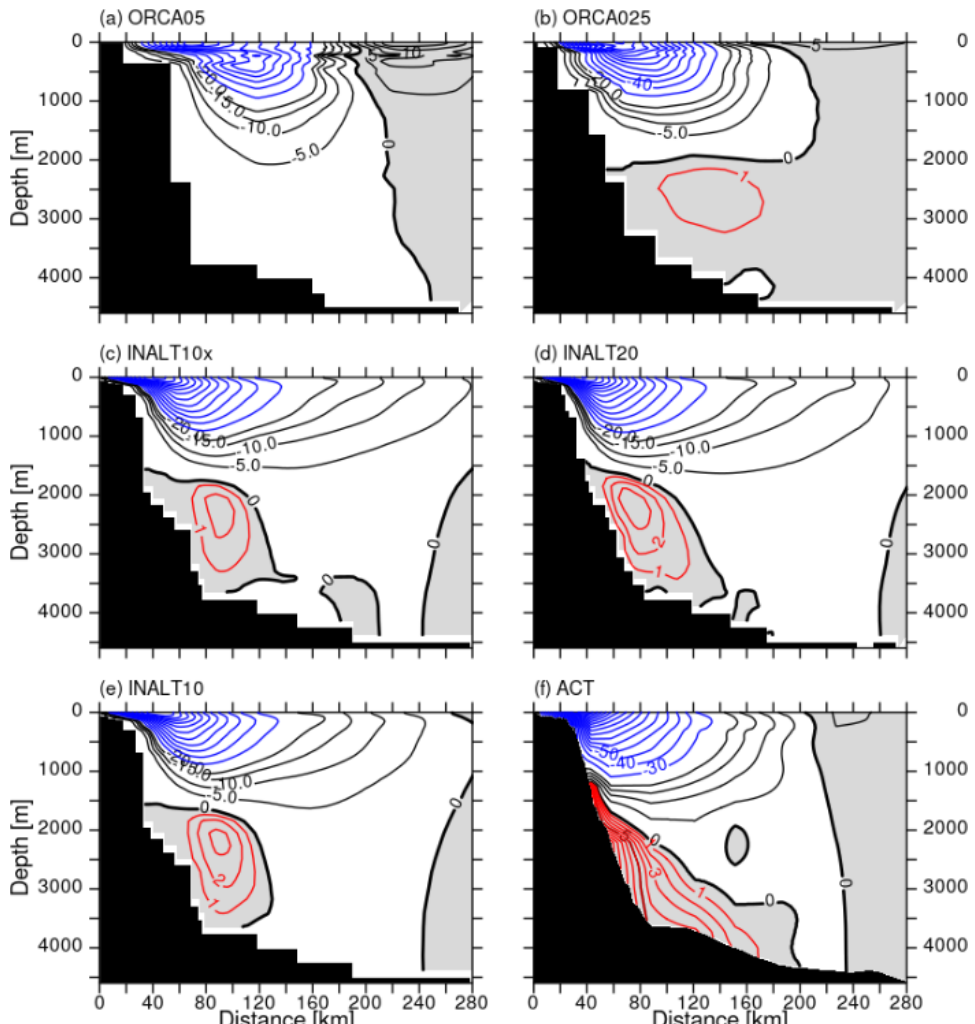
Figure 13. Velocity section perpendicular to the ACT section at ∼ 34 ◦ S for the simulations ( a – e ) averaged from 2005 to 2009 and for the observations (f) averaged between 17 April 2010 and 19 February 2013. Southwestward/negative velocities (AC) are shaded in white and northeastward/positive (AUC) in grey; contoured are intervals of 1cms − 1 in red, 5cms − 1 in black and 10cms − 1 in